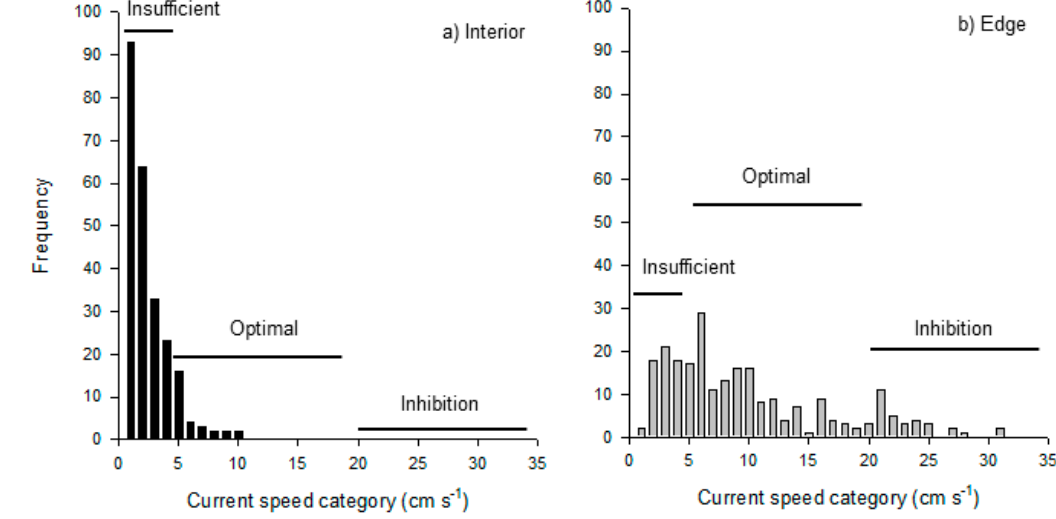
Figure 5. Current speeds occurring in the ( a ) interior and ( b ) along the edge of the kelp forest at MOHK during the growth experiment. Data are a frequency of 30 min periods in which the current speed was 0 to 35 cm s − 1 (N = 242 periods). Insufficient, optimal, and inhibition labels are based on Figure 1 in Arkema 2009.